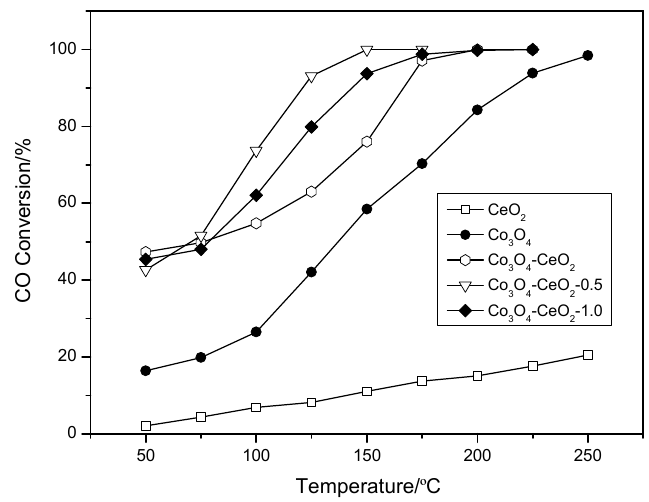
Figure 1. CO conversions over Co ‐ based catalysts.